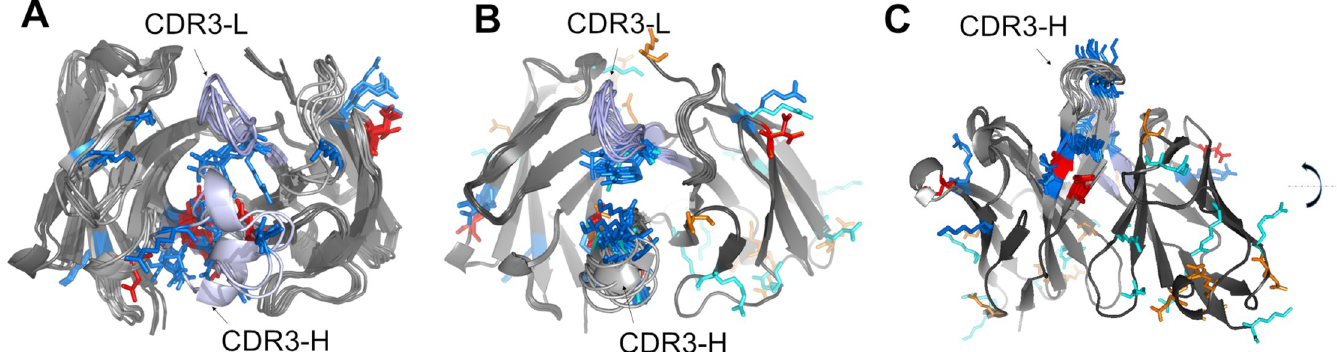
Fig 13. Using multiple Ab models to account for the CDRs flexibility and variations of side-chain orientation. (A) Superposition of 3-D models of seven EBOV Abs (ADI-15974, ADI-15756, ADI-15758, ADI-15999, ADI-15820, ADI-15848, ADI-16061) that target the stalk region of EBOV GP. For simplicity, the Abs are represented using grey ribbon models with positively- and negatively-charged residues associated with the CDRs shown with a ‘stick’ representation in blue and red, respectively. The light gray fragments of the ribbon models highlighted the positions of the light-chain CDR3s (CDR3-L), and heavy-chain CDR3s (CDR3-H). (B) Superposition of ten 3-D models of Ab ADI-15974 shown in the same orientation as those in (A) and using the same color scheme. Variations in the PDB templates used by Rosetta Antibody for 3-D models generation can lead to differences in the CDRs, and variations in the fingerprint patterns. In addition, for one of the models, we display the remaining positively- and negatively-charged residues of the Ab using cyan and orange colors, respectively. Note that projections of the latter set of residues may also contribute to the fingerprint patterns. (C) Same models as in panel B viewed using a 90˚ rotation around the horizontal axis.